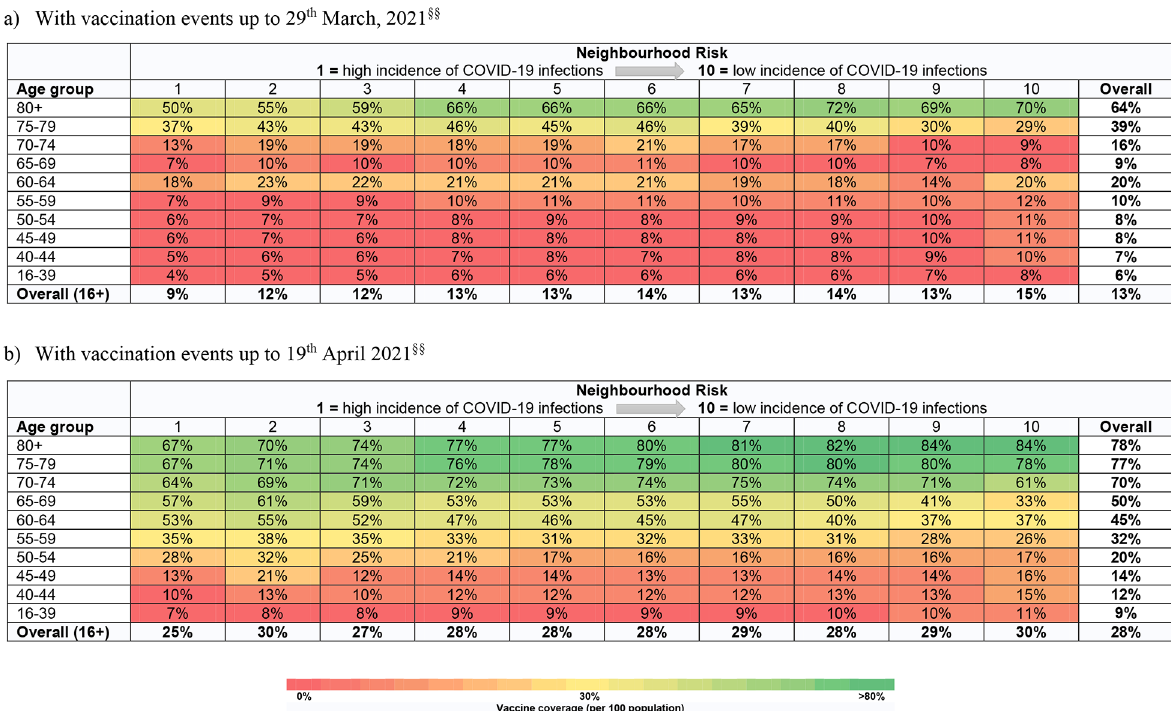
Figure 3: Example exhibits on COVID-19 vaccine coverage from ICES COVID-19 Dashboard ∗∗ - Percentage of Ontarians who have received at least 1 dose of a COVID-19 vaccine (vaccine coverage) by age group and neighbourhood COVID-19 infection risk as of a) 29 th March 2021 and b) 19 th April 2021